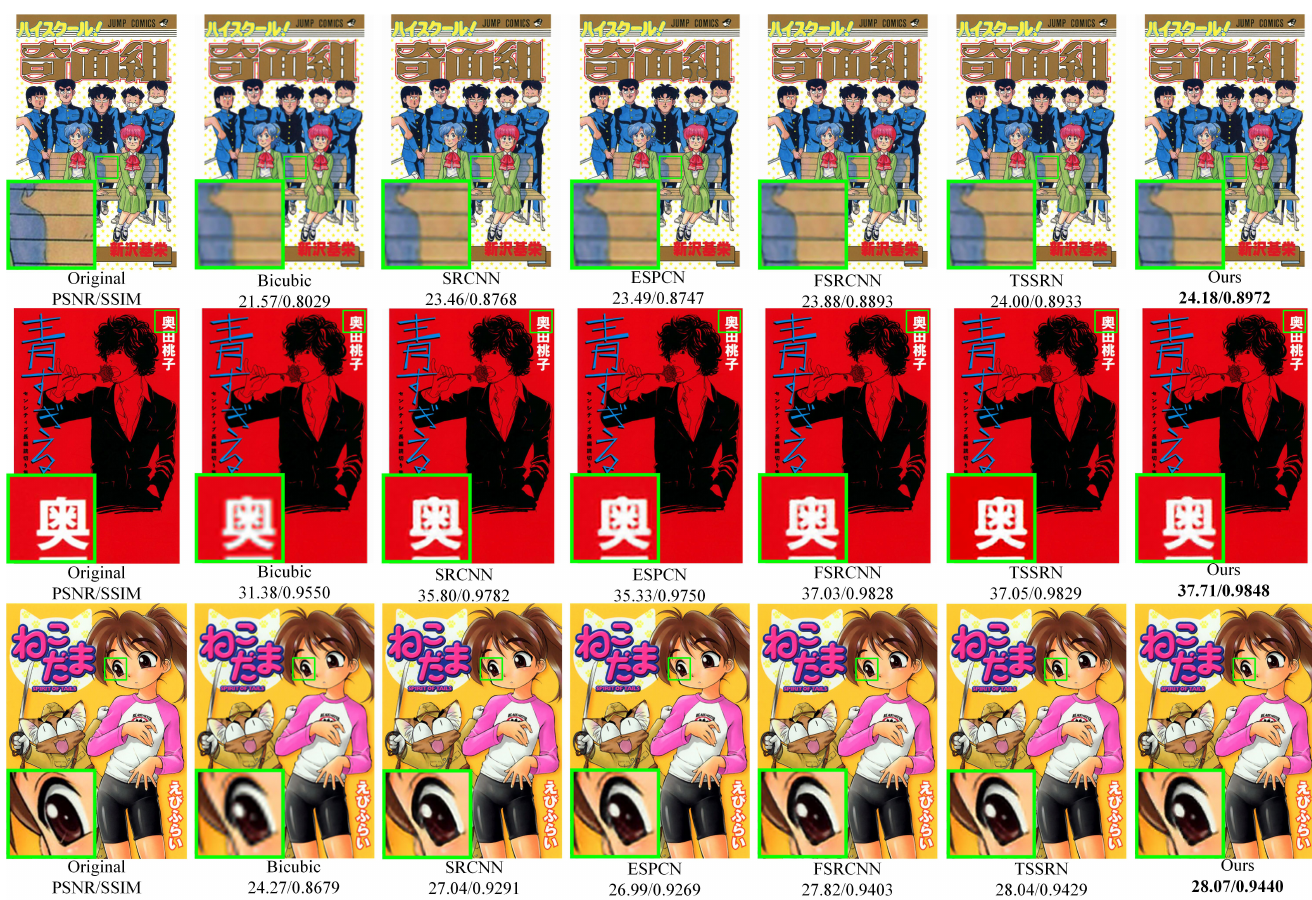
Figure 6. The “HighschoolKimengumi_vol20”, “AosugiruHaru” and “Nekodama” images from the Manga109 dataset with an upscaling factor of